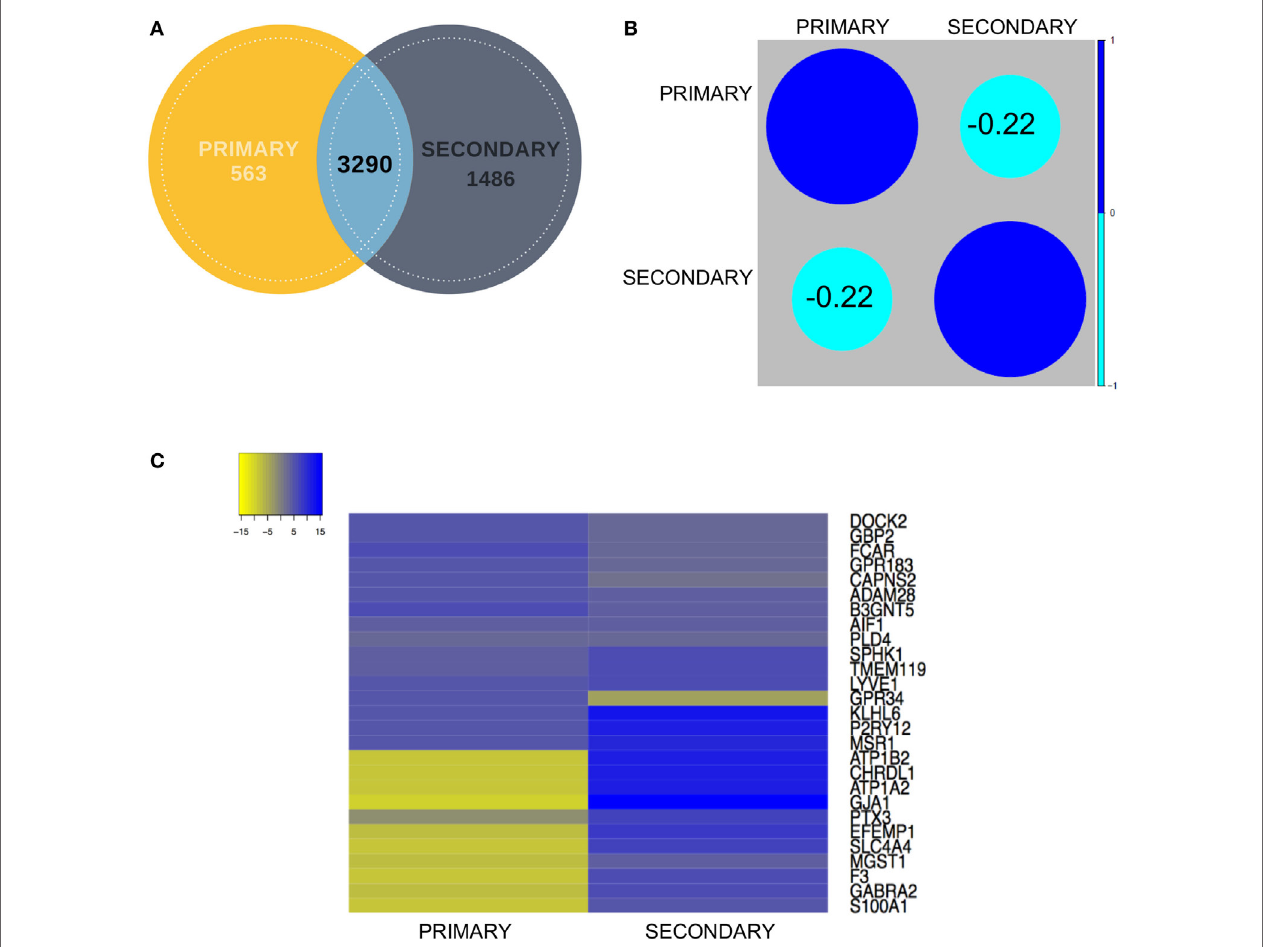
FigUre 3 | (a) Venn diagram showing contribution of each dataset (primary and secondary) to the overlapping gene pool. (B) Correlation analysis between the primary and secondary datasets showed mildly negative correlation. (c) Representative expression heatmap between the final shortlisted 27 genes has been elaborated in the expression map for in-depth correlation